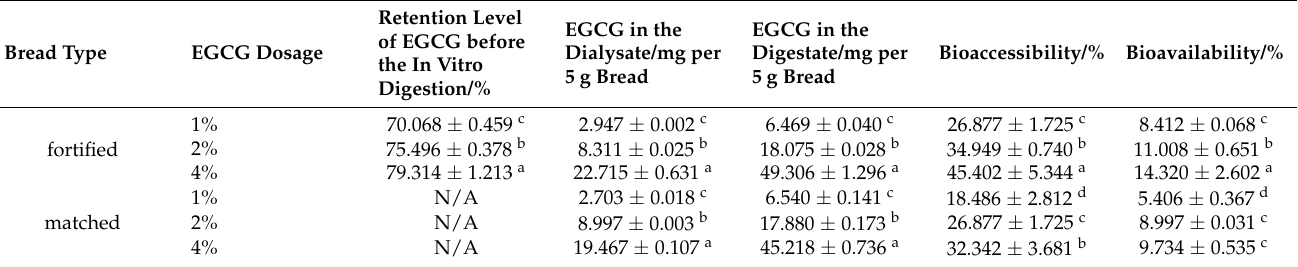
Table 3. Quantification of EGCG in the dialysate and digesta of fortified/matched bread at different EGCG dosages after in vitro